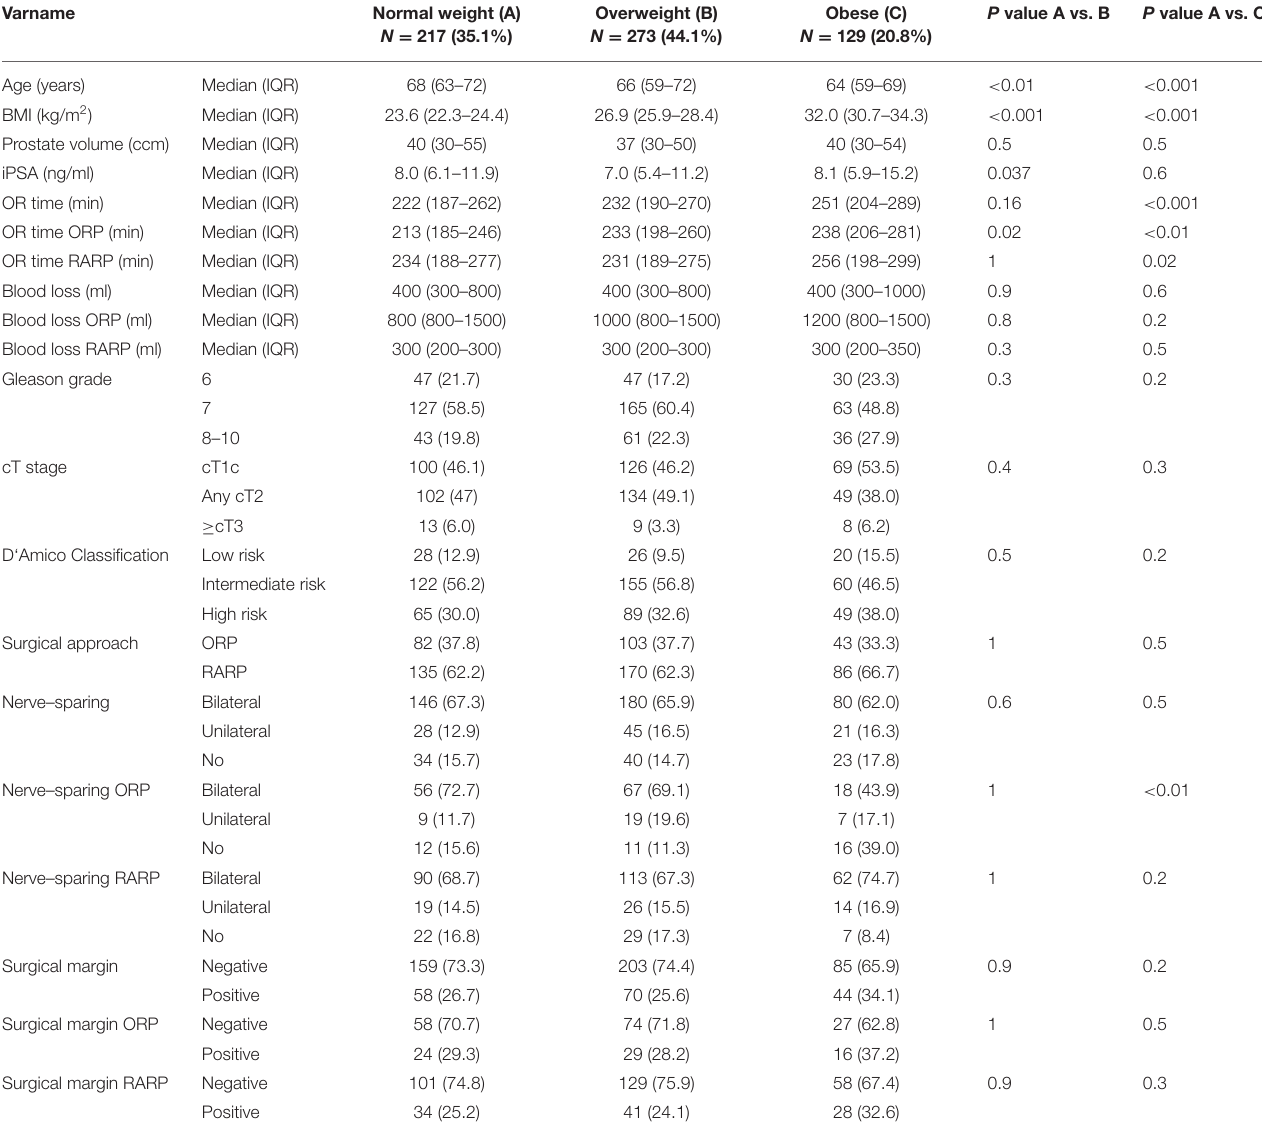
TABLE 2 | Patient characteristics stratified by